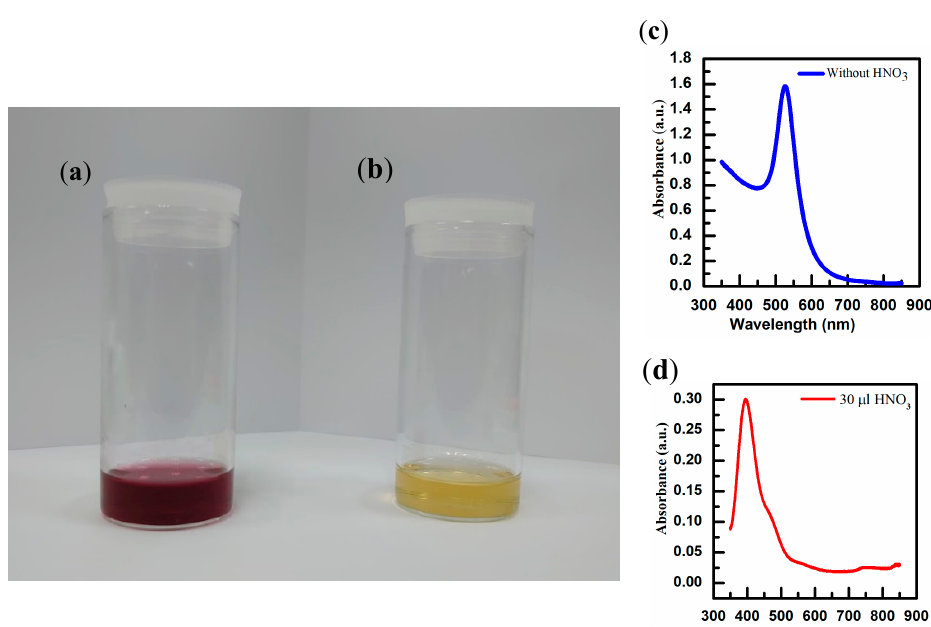
Figure 8. The growth solution with and without nitric acid. ( a ) The growth solution color without nitric acid. ( b ) The growth solution color with nitric acid. ( c ) The absorption wavelength without nitric acid. ( d ) The absorption wavelength with 30 μ L nitric acid.